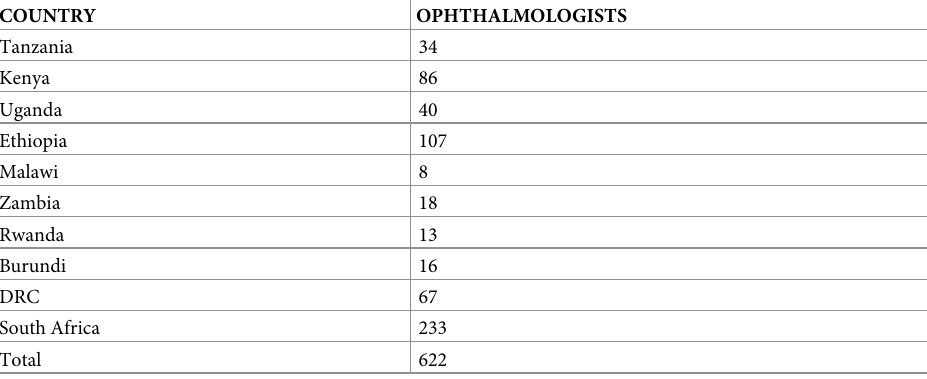
Table 1. Distribution of Ophthalmologists in the study